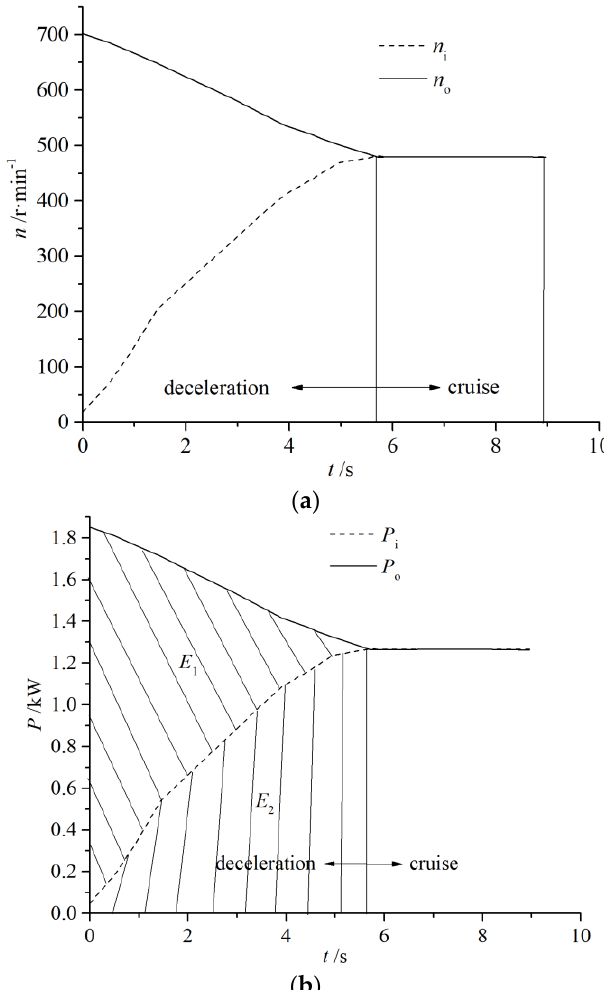
Figure 11. Experimental results of lower power transmission: ( a ) electromagnetic coupler mechanical port speed; ( b ) electromagnetic coupler mechanical port power.